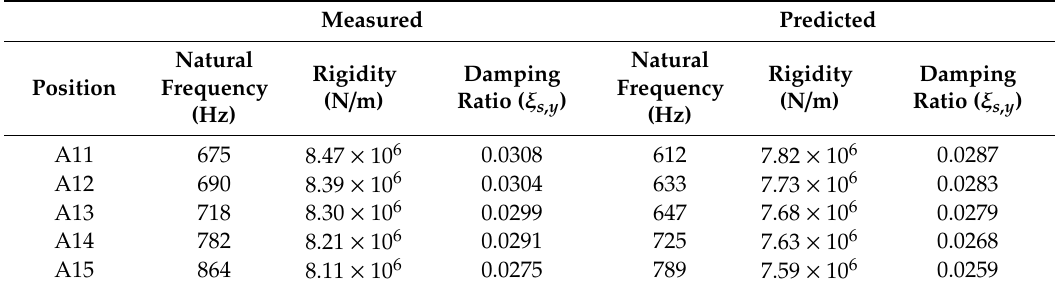
Table 2. The modal parameters of the workpiece at different machining positions. Measured